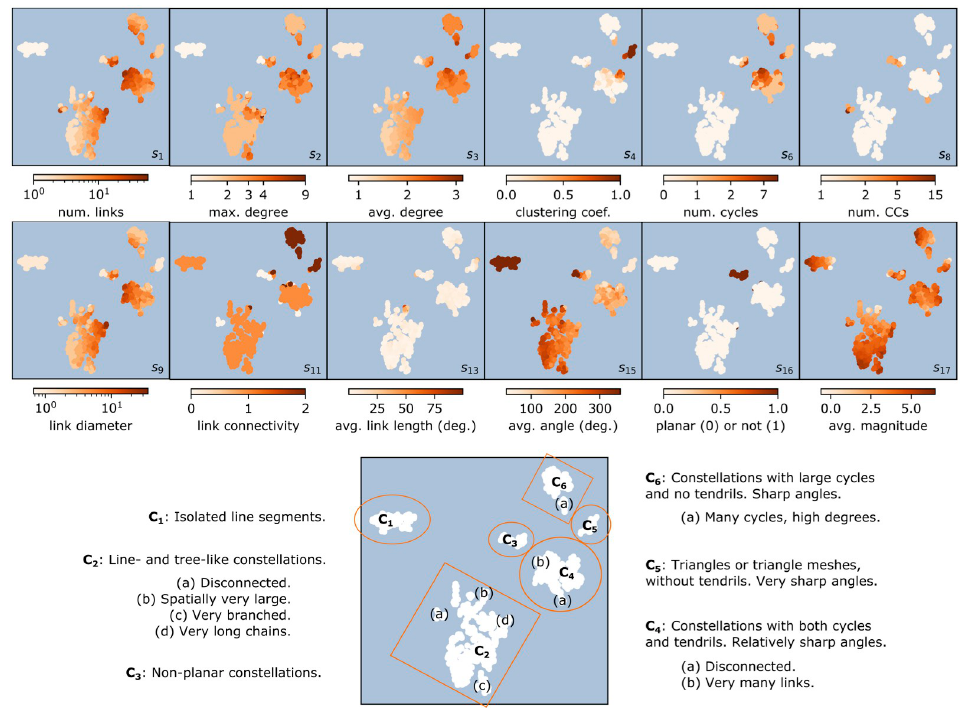
Fig 4. The map of constellation features in two embedded dimensions. All plots show the same embedding. One point represents one constellation. (top) The gradient of each constellation feature, as projected in the low-dimension space. Twelve constellation features are shown. (bottom) A summary of the